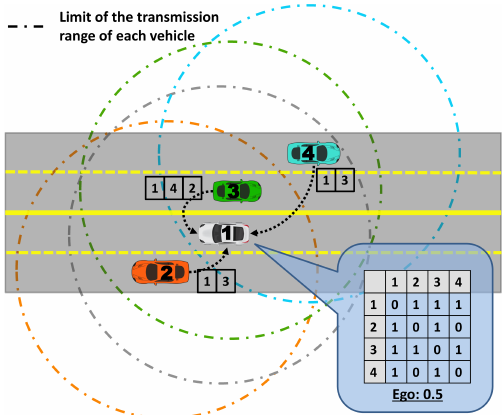
Figure 4. An illustrative example of the beacon packets’ exchange among the vehicles to calculate the egocentric betweenness score. In this case, the grey vehicle, labelled as 1, is doing the